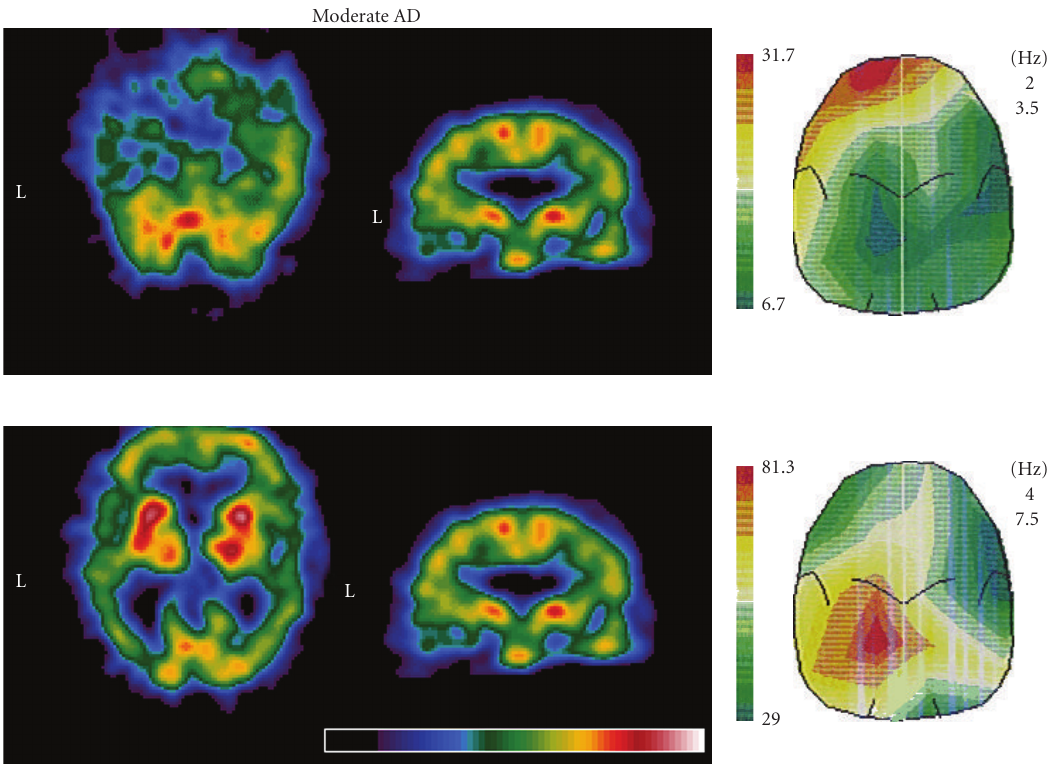
Figure 4: Sample of SPECT neuroimaging (Tc-99 HMPAO) and EEG brain mapping in a moderate AD patient. Topographic scalp distribution of the EEG power on the 2.0 to 3.5Hz frequency band (top right) and 4.0 to 7.5Hz frequency band (bottom right) is shown. For more details, see